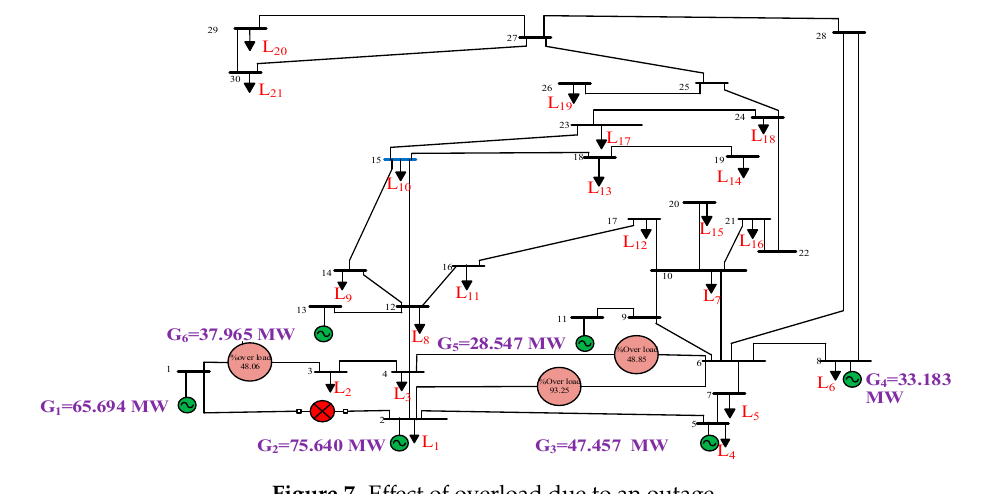
Figure 6. Power violation between lines due to line outage between lines 1–2.